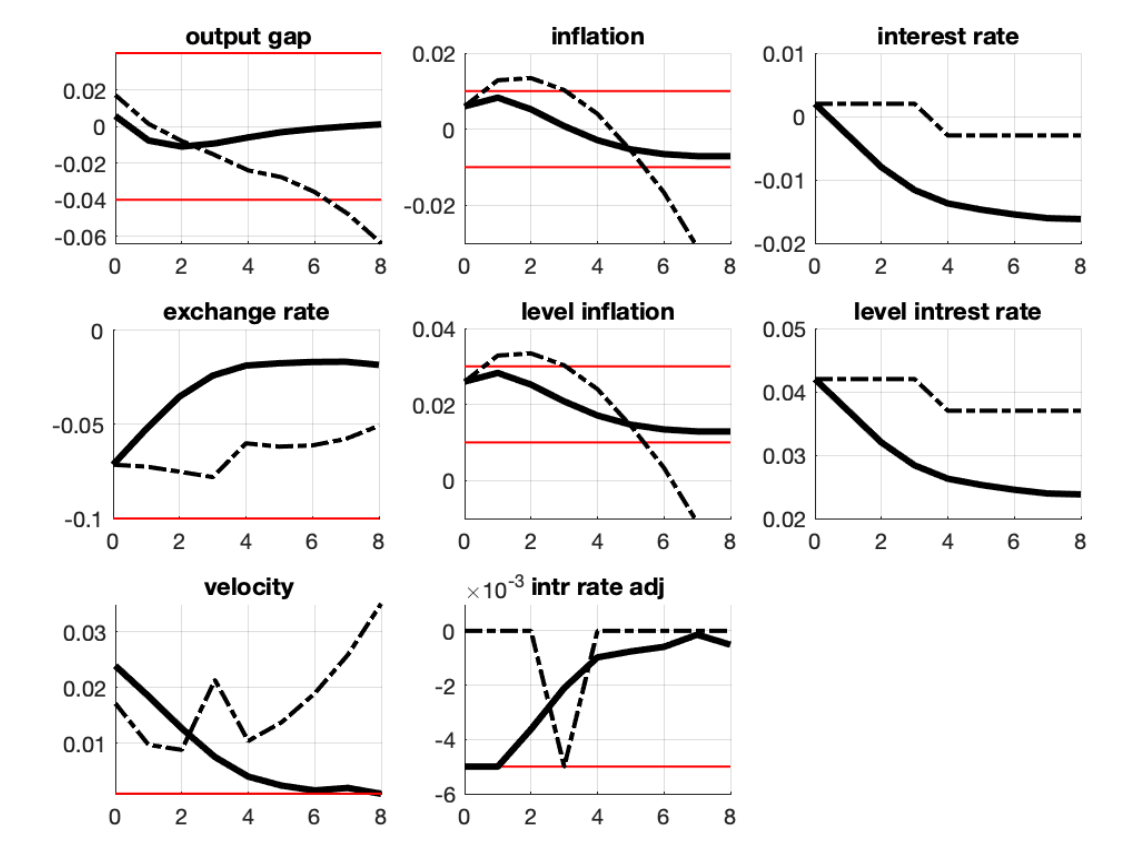
Figure 3. Time profiles of economy